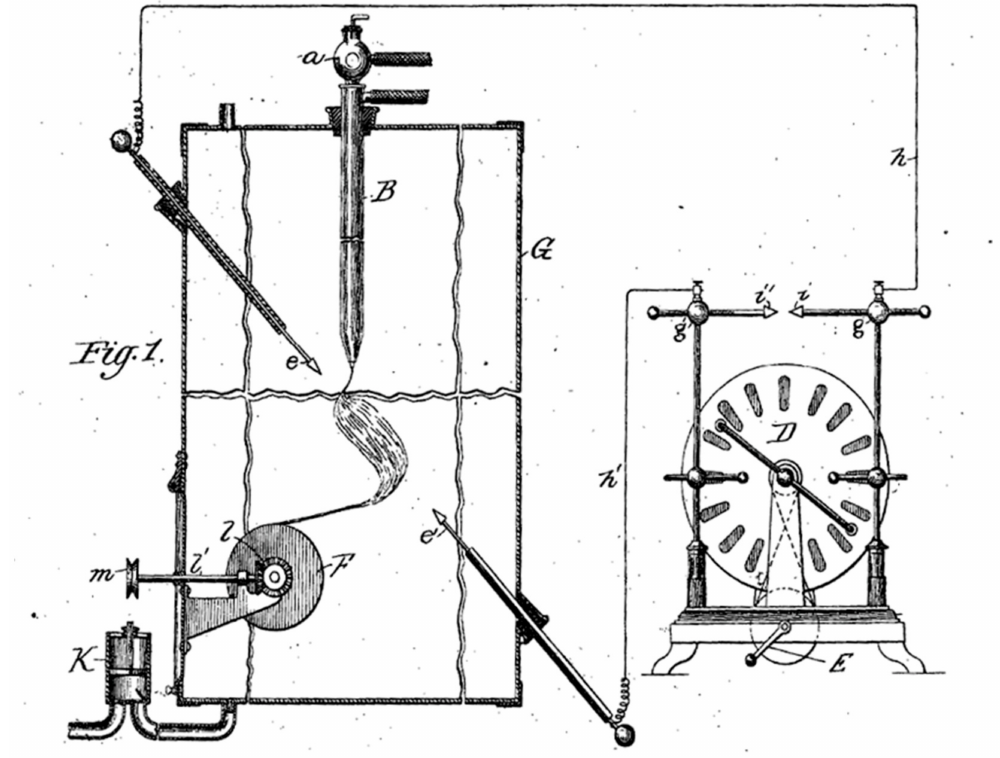
Figure 2. The schematic drawing of Cooley’s electrospinning device. Enclosed in the electrospinning chamber ( G ), the capillary ( B ) delivers the polymer solution into the electric field between two opposite electrodes (e and e’), thereby generating a stream of jets which solidifies into fibers. The fibers, on their flight towards the electrode e’, are intercepted by a glass rod (not shown in the diagram) and thus are bundled together and brought to a reel ( F ) which winds the bundle. The pump K evacuates the spinning chamber for a possible solvent recovery. D is a Wimshurst machine (or any suitable machine) for generating high voltage. Reprinted with permission from Ref. [18]. Copyright 1900 United Kingdom